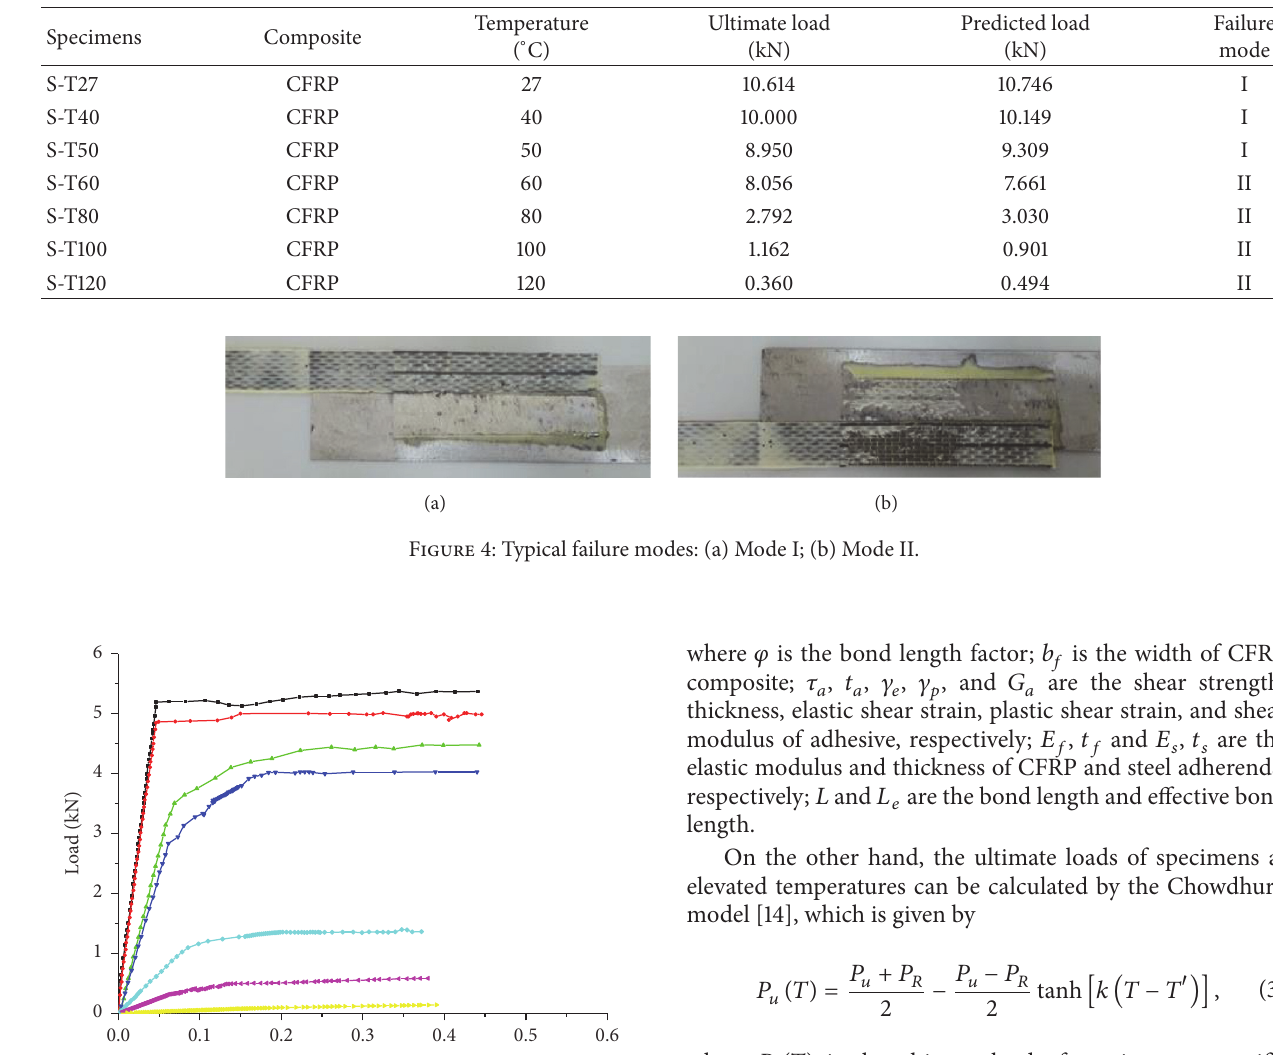
Table 2: Test results of all specimens.